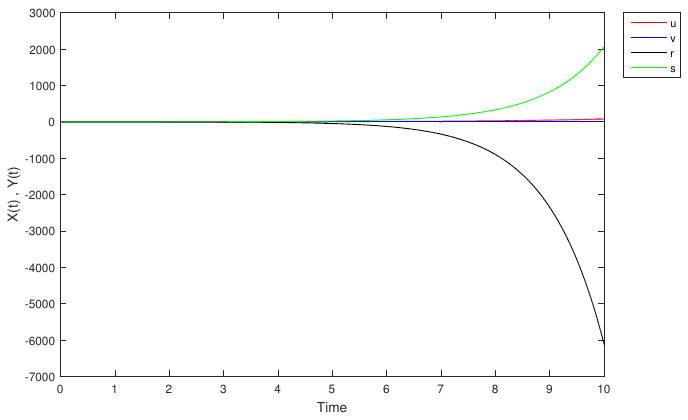
Figure 24. The solution of (12) at α = 0.5. At α -level = 1, the solution is shown in Figure 25: